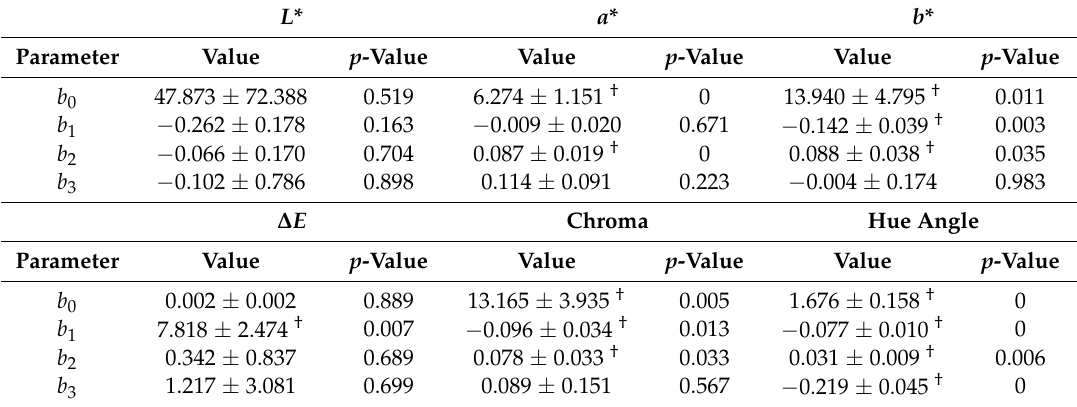
Table 5. Non-linear regression models coefficients for description of colour component change during